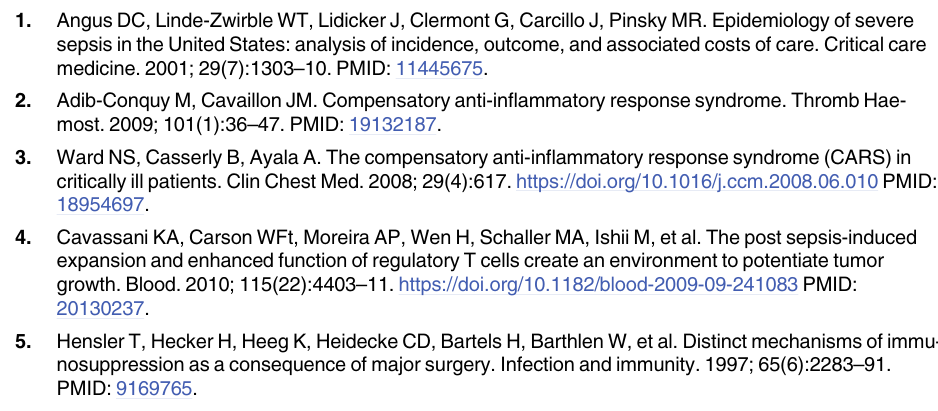
S4 Fig. Gating for B cells and germinal center B cells. Sepsis was induced in C57BL/6 mice by AP. After seven days, B cells and germinal center (GC) B cells in the spleen were determined by flow cytometry. The gating strategies for CD19 + B220 + B cells (A) and B220 + GL7 + IgD - CD95 hi CD73 int GC B cells (B) are shown. S5 Fig. NSI did neither cause disease symptoms nor death. C57BL/6 mice were non-specifi- cally immunized (NSI, n = 29). Untreated animals (n = 12) and animals in whom sepsis has been induced by AP (n = 23) served as controls. (A) The survival of the animals was closely monitored over three days. Survival differences were analyzed with log rank test. (B) In addi- tion, the severity of illness was determined as a sum of scores assessing general appearance, breath, provoked and spontaneous behavior. (C) At the same time the body temperature of the animals was determined. Means and standard errors are shown. The results are pooled from two independent experiments. Group differences between "untreated" and "NSI" (#) or "AP" and "NSI" ( (cid:3) ) were tested for significance with the Mann-Whitney test. (cid:3) / # P < 0.05; (cid:3)(cid:3) / ## P < 0.01; (cid:3)(cid:3)(cid:3) / ### P < 0.001.